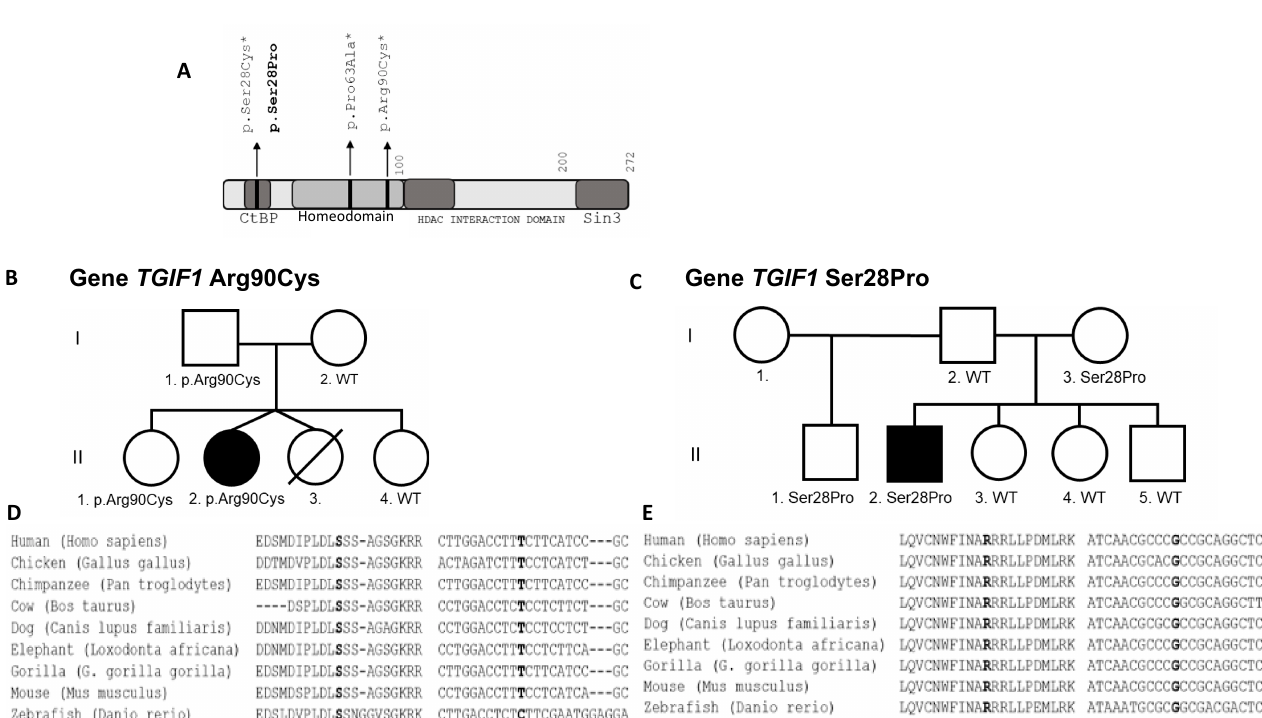
Figure 4. Segregation of TGIF1 variants and evolutionary conservation. ( A ) Human missense variants in TGIF1 are indicated in the protein diagram. Two variants are in the CtBP domain of TGIF1 which normally interacts with the carboxy terminus binding protein to repress expression of target genes. TGIF1 is a member of the three amino acid loop extension (TALE) homeodomain family of genes, and two variants are in this DNA binding domain. The variants in bold are from the present study, and the other two variants were previously shown to be deleterious in functional studies. The histone deacetylase (HDAC) interaction domain and Sin3a domains of TGIF1 are also important for repression. ( B ) Family pedigree showing segregation of TGIF1 p.Arg90Cys variant present in the heterozygous state in the proband, II.2, and her unaffected father and sister, I.1 and II.1, respectively. Her mother and sister, I.2 and II.4, are homozygous for the normal allele. ( C ) Family pedigree showing segregation of TGIF1 p.Ser28Pro variant present in a heterozygous state in the proband, II.2 and his unaffected mother and half-brother. The father, I.2, and the siblings, II.3, II.4 and II.5 are homozygous for the normal allele. ( D ) TGIF1 protein ( left ) and cDNA ( right ) are evolutionarily conserved in the region around Ser28. The amino acid and nucleotide mutated in p.Ser28Pro are in bold. ( E ) TGIF1 protein ( left ) and cDNA ( right ) are evolu- tionarily conserved in the region around Arg90. The amino acid and nucleotide mutated in p.Arg90Cys are in bold.